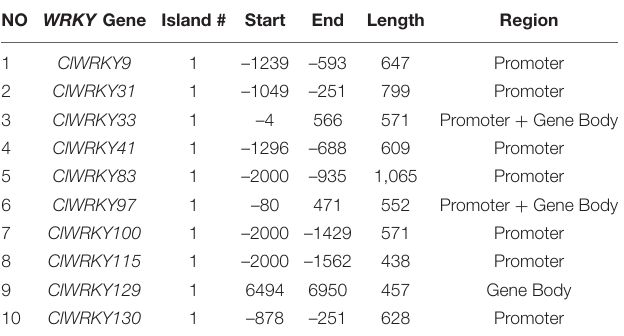
TABLE 1 | Details of each of the ten genes with a CpG island.